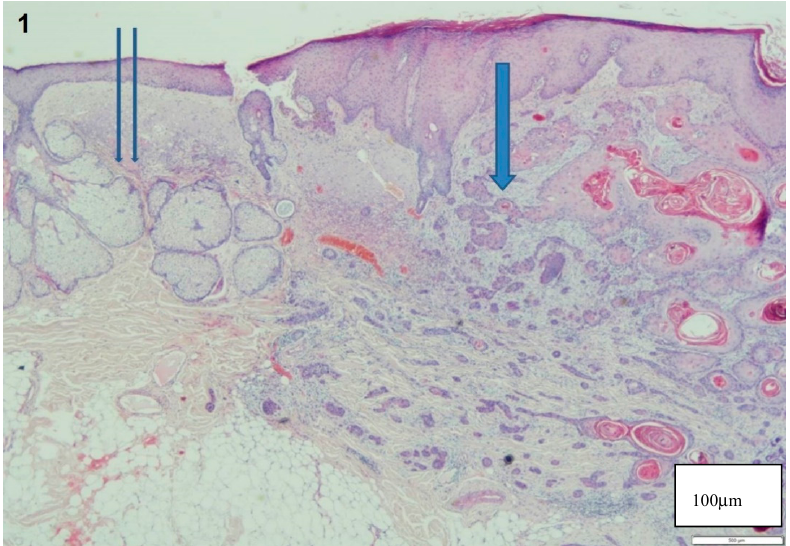
Figure 1. Histological findings of SCC in H and E-stained slide. Note the invasion of dermis by atypical keratinocytes with squamous eddies and pearls and dyskeratosis in the tumor ( arrow ) and the normal tissue ( 2 arrows ).